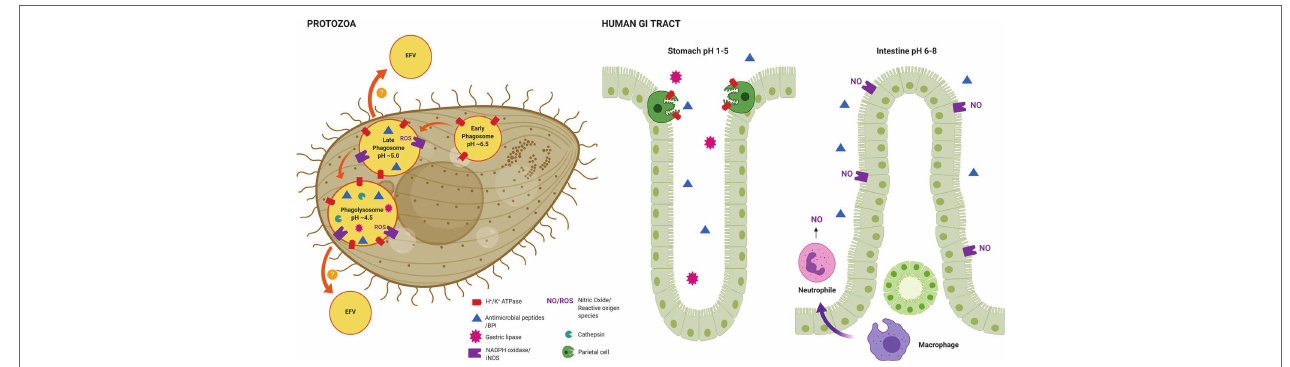
FIGURE 2 | Representation of the conserved factors required for the inactivation and digestion of bacteria used by both protozoa and the innate defense system of the human GI tract. The maturation of bacterial-containing phagosomes in Tetrahymena (Protozoa), a process that depends on acidification. As shown, different factors are recruited at different stages of the phagosome maturation process. Some pathogenic bacteria, such as Vibrio spp., are able to resist the digestion process and are expelled in EFVs to the extracellular environment, a condition where they show a hyperinfective phenotype in vivo . From left to right in human GI tract, the antimicrobial strategies deployed by the stomach and the intestinal tract. The factors represented here are highly similar to the ones encountered in phagocytic protozoa, thus, the pre-adaptation to such stressors within protozoa might be crucial for pathogenic bacteria to survive and multiply within the human GI tract. The figure was created with